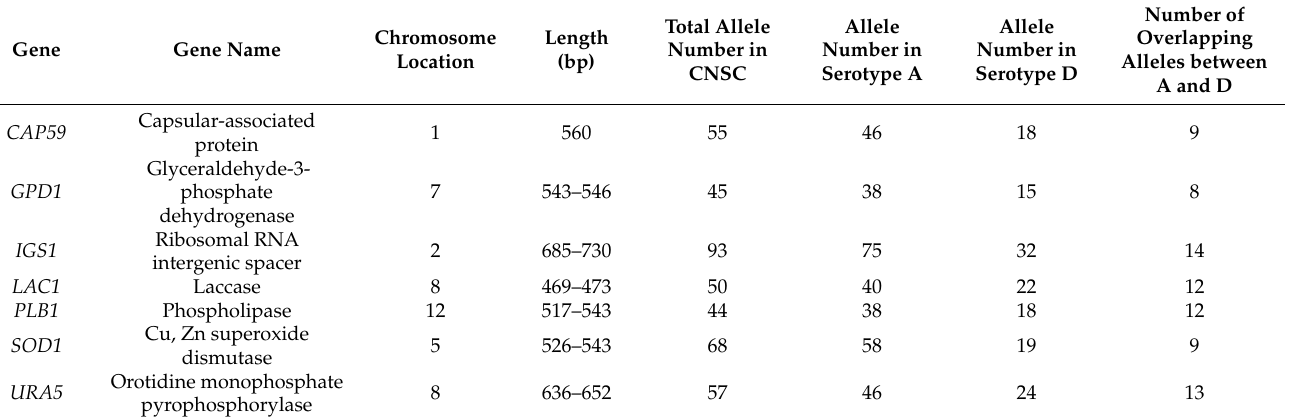
Table 3. Allelic variation among the seven loci used for the multilocus sequence typing of the C. neoformans species complex. The number of overlapping alleles at each locus between the serotype A and serotype D strains was calculated based on the assigned molecular types by the MLST database.